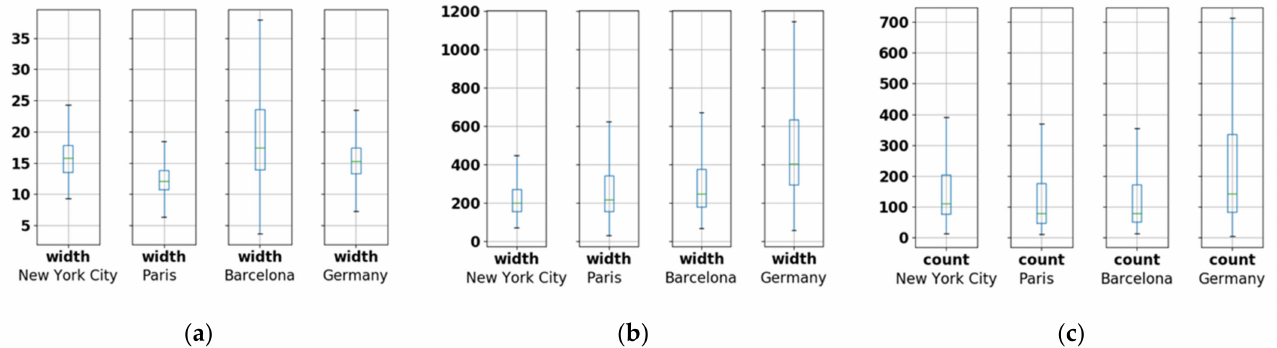
Figure 1. ( a ) A boxplot of average building footprint width in each data sample for each of the experiment classes in the units of meters. ( b ) A box plot of the width of data samples for each of the experiment classes in meters. ( c ) A boxplot of the building count in each data sample grouped by experiment